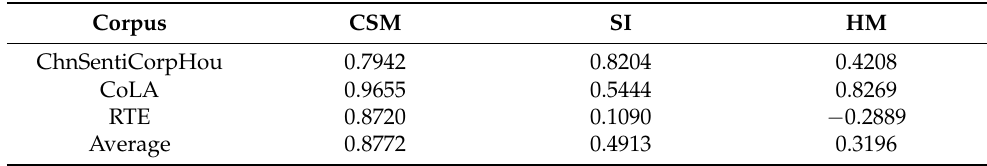
Table 2. The Pearson’s correlation coefficients between test accuracy and each of the three separabil- ity